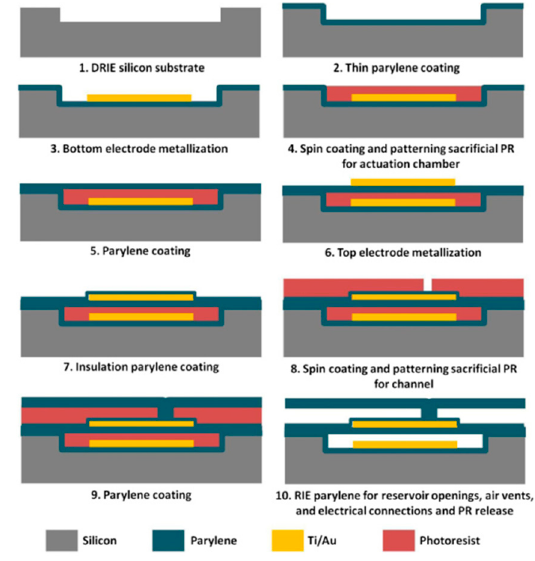
Figure 2. Fabrication process flow of electrostatic actuated microvalve [32].